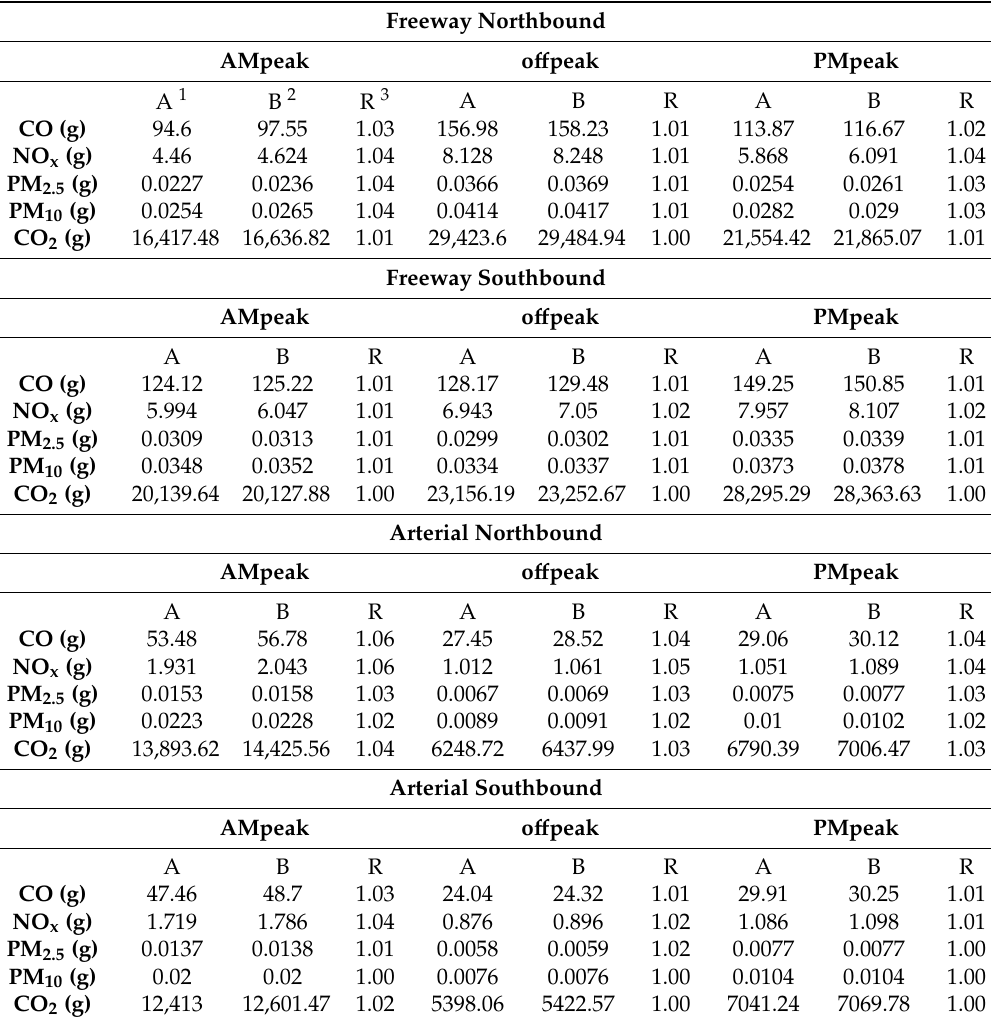
Table 3. Comparison of link emission estimation